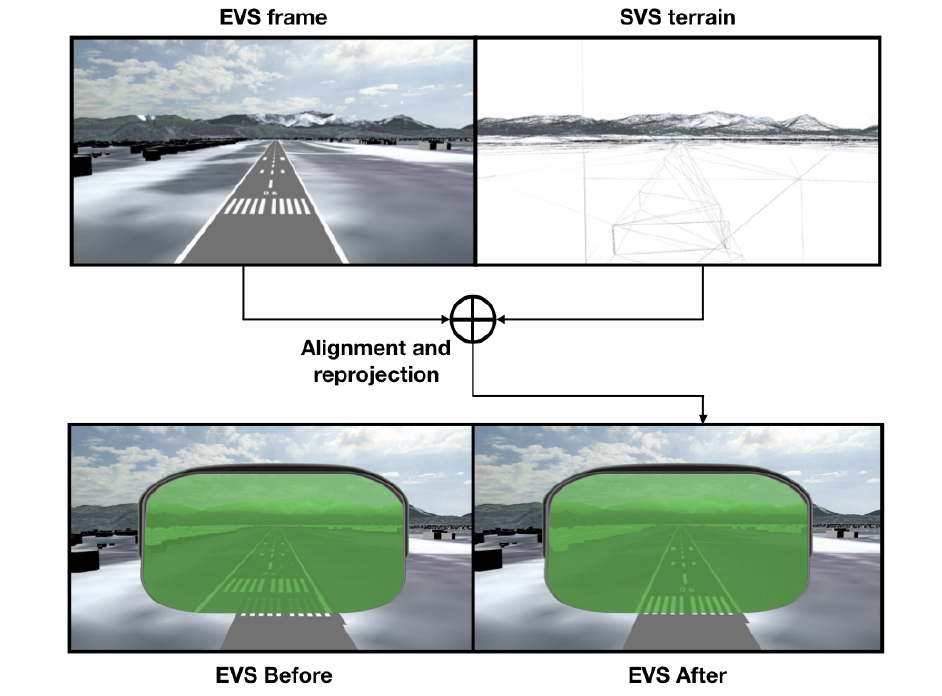
Figure 4. Enhanced vision system image reprojection for conform representation on the pilot’s